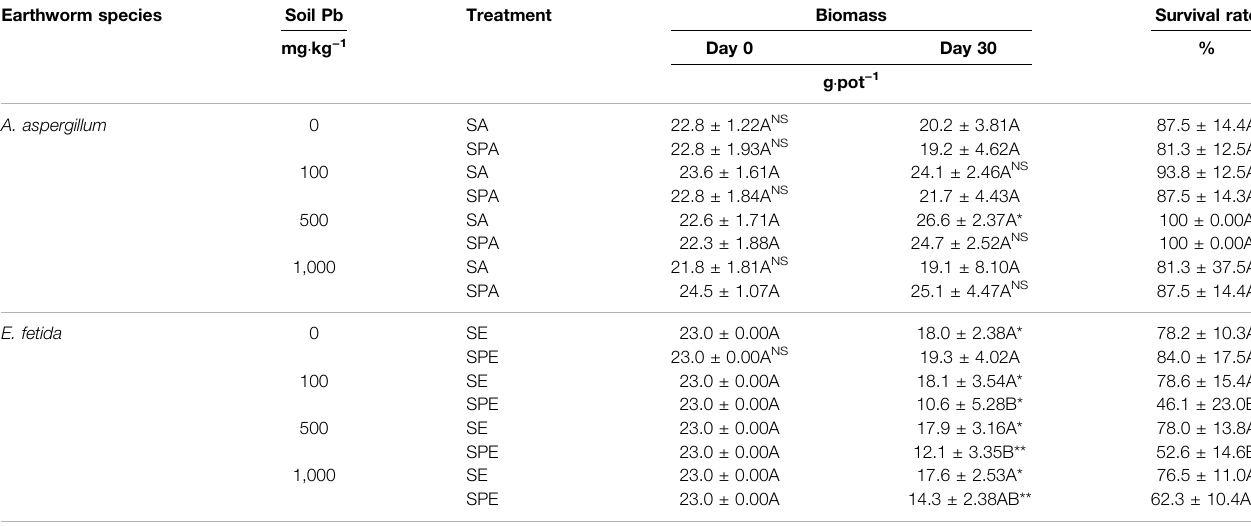
TABLE 1 | Biomass and survival rate of the two earthworm species, Amynthas aspergillum and Eisenia fetida , in the treatments with different soil Pb concentrations. Earthworm species